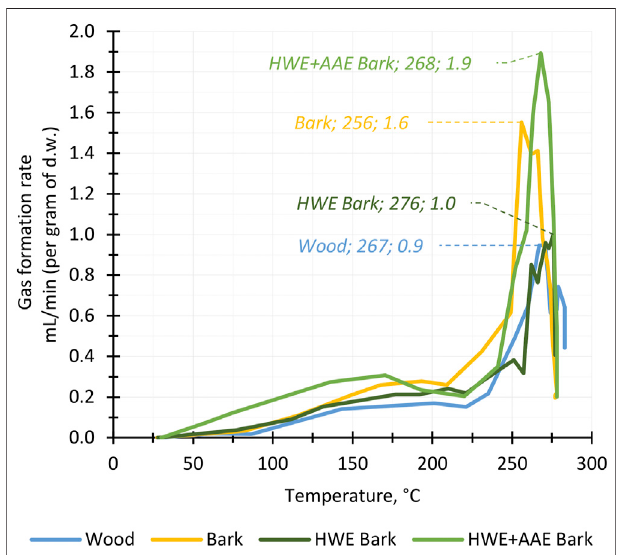
FIGURE 3 | Gas production of hybrid aspen biomass fractions and pre- extracted bark masses ( HWE , hot water extraction; AAE , alkaline alcohol extraction) during the torrefaction process. The maximum gas formation rate for each feedstock at different temperatures is highlighted in the diagram.